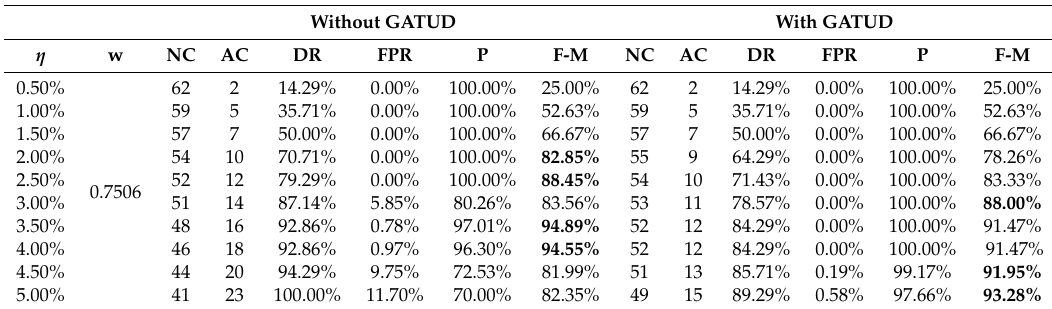
Table 9. The detection accuracy of the proximity-detection rules that have been extracted with/without the integration of GATUD in the separation process on DUWWTP. Without GATUD With